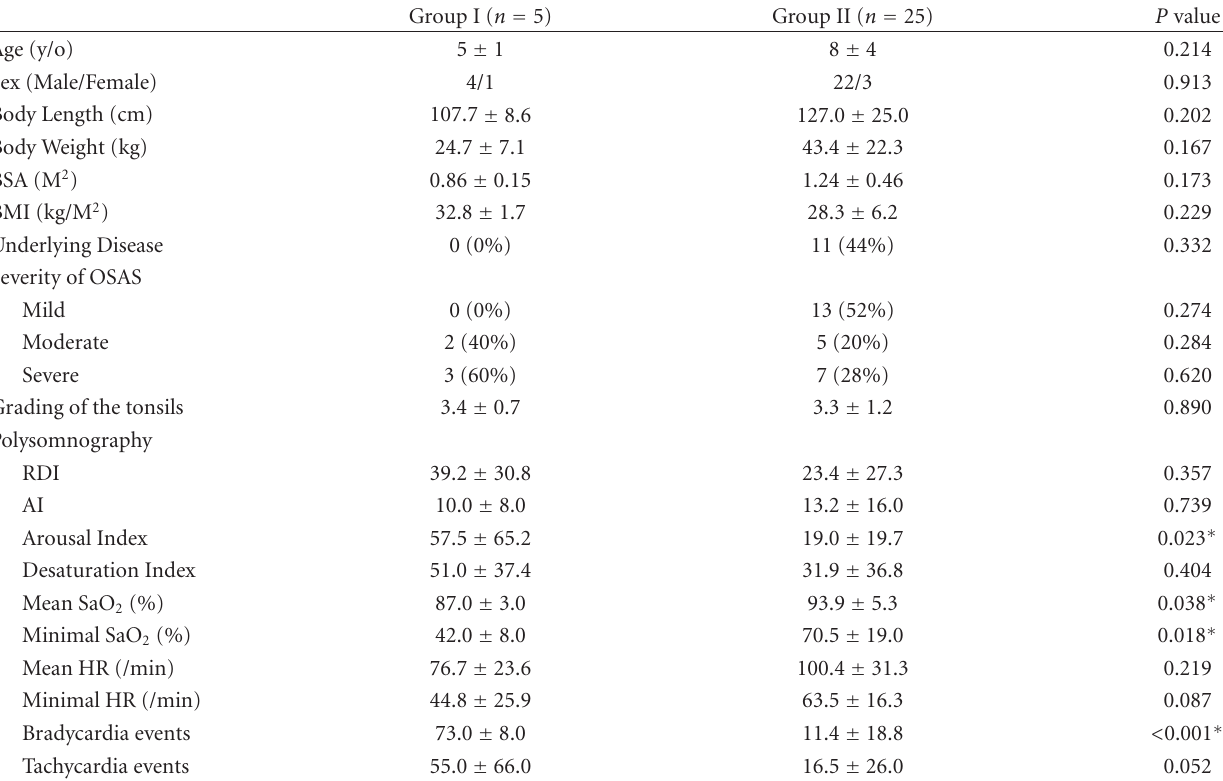
Table 1: A comparison of the demographic, clinical, and polysomnographic characteristics between the two children groups with